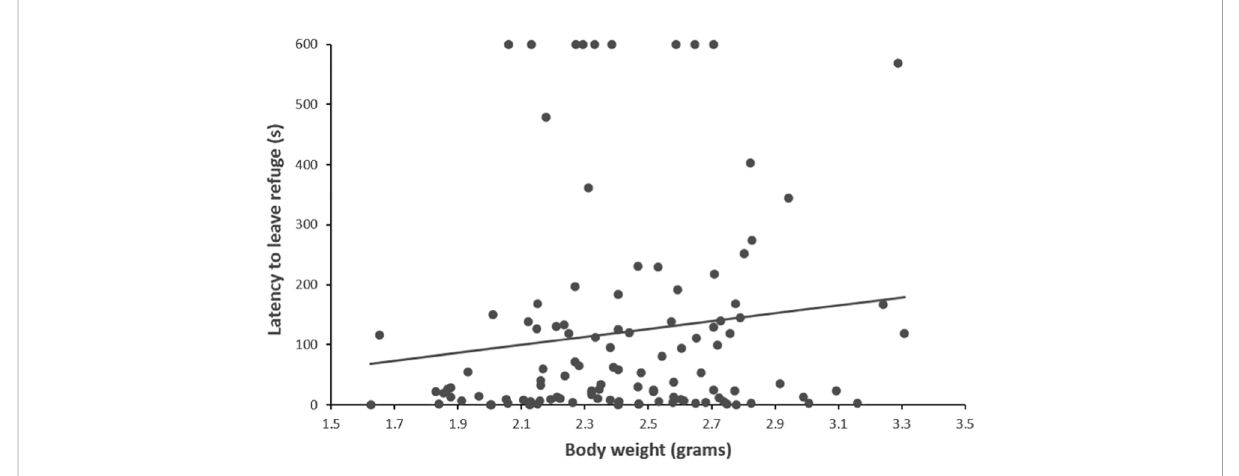
FIGURE 3 The relationship between body size (grams) and latency to leave the moss refuge (seconds) in adult P. corroboree (n = 115). Data shown are